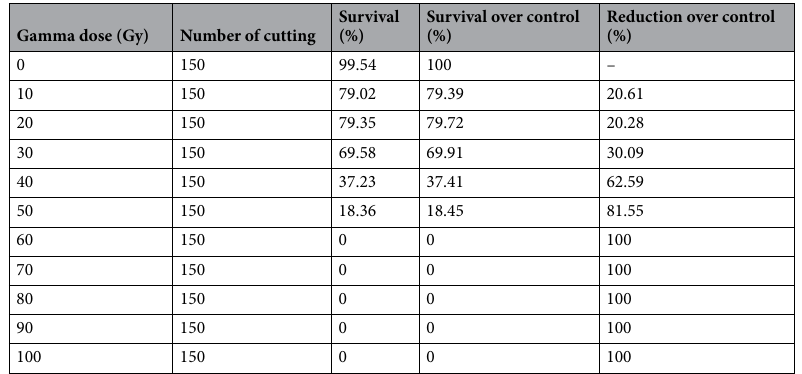
Table 1. The effect of different gamma irradiation doses on survival of hardwood cuttings of ‘Yaghouti’ grape ( Vitis vinifera L.) cultivar. The means with same Duncan’s multiple range test letters in each column are not statistically significant ( P ≤ 0.01). Data are average of four replications ± SE.